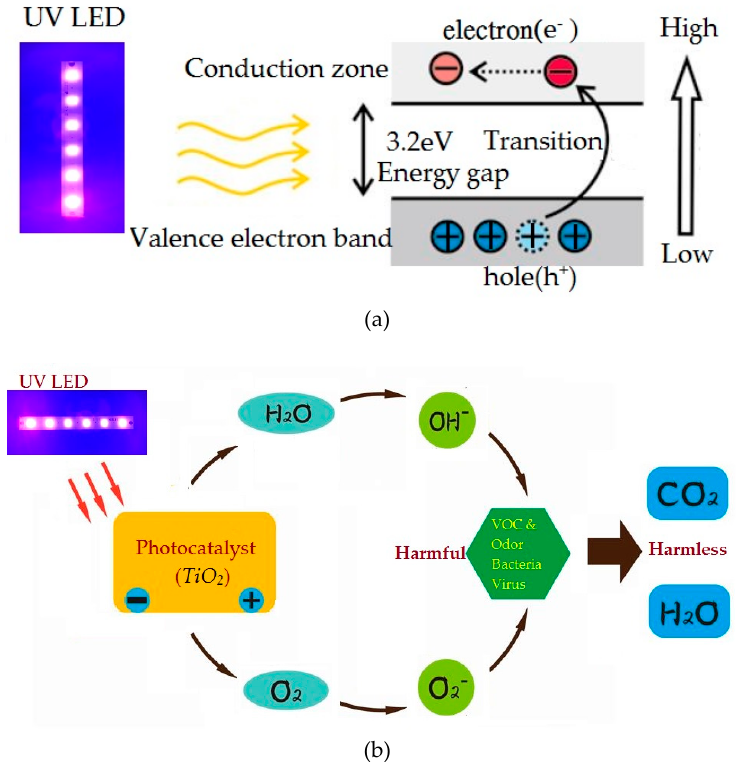
Figure 5. ( a ) TiO 2 photocatalyst energy-band structure; ( b ) TiO 2 photocatalyst CO 2 -producing reaction mechanism.